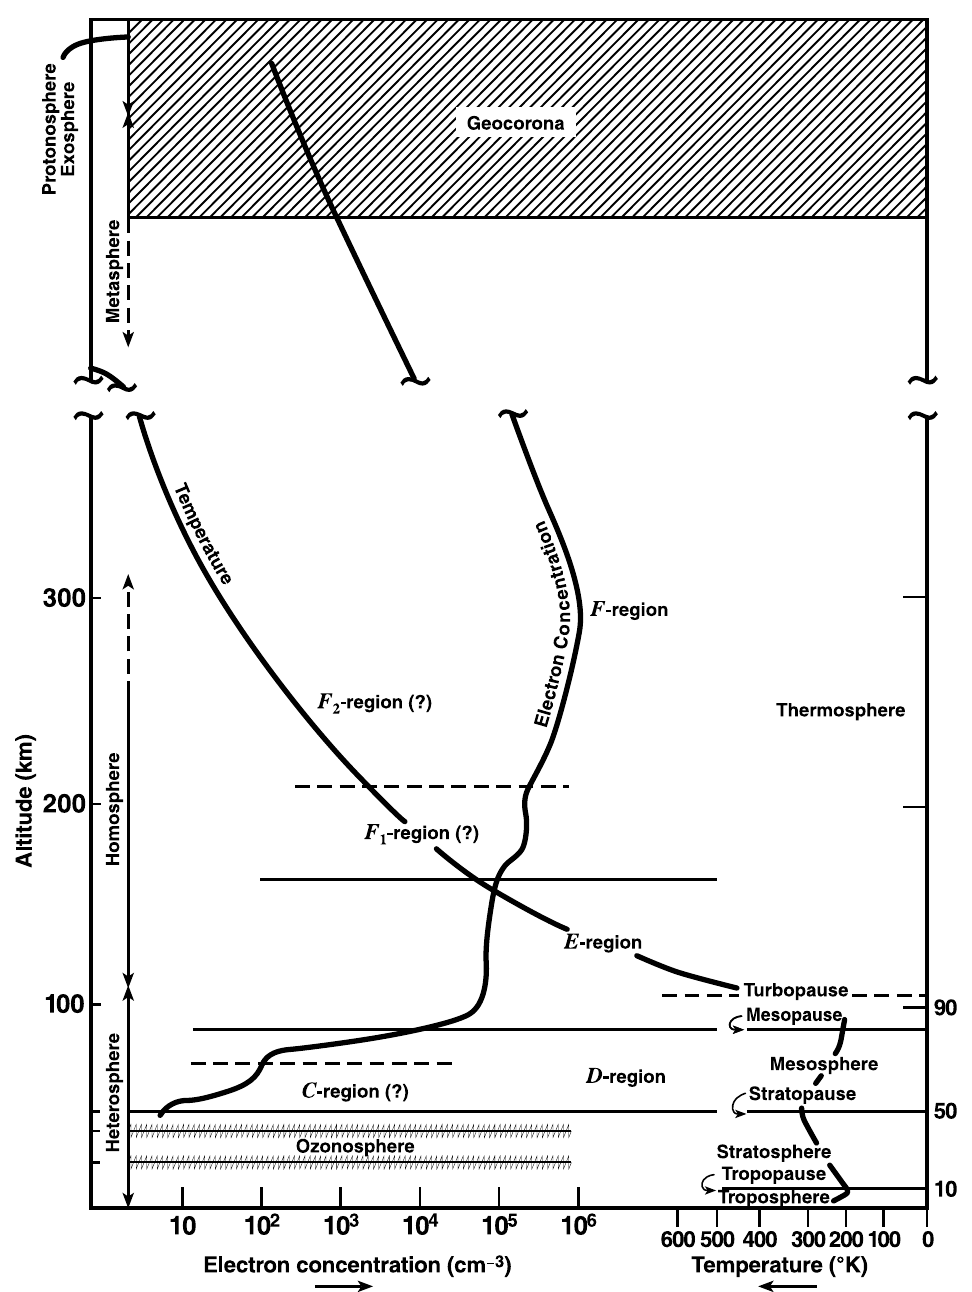
Fig. 1. Schematic representation of atmospheric regions. Classification of atmospheric layers in accordance with temperature (right) and with electron concentration (left) (Whitten and Popoff, 1971)